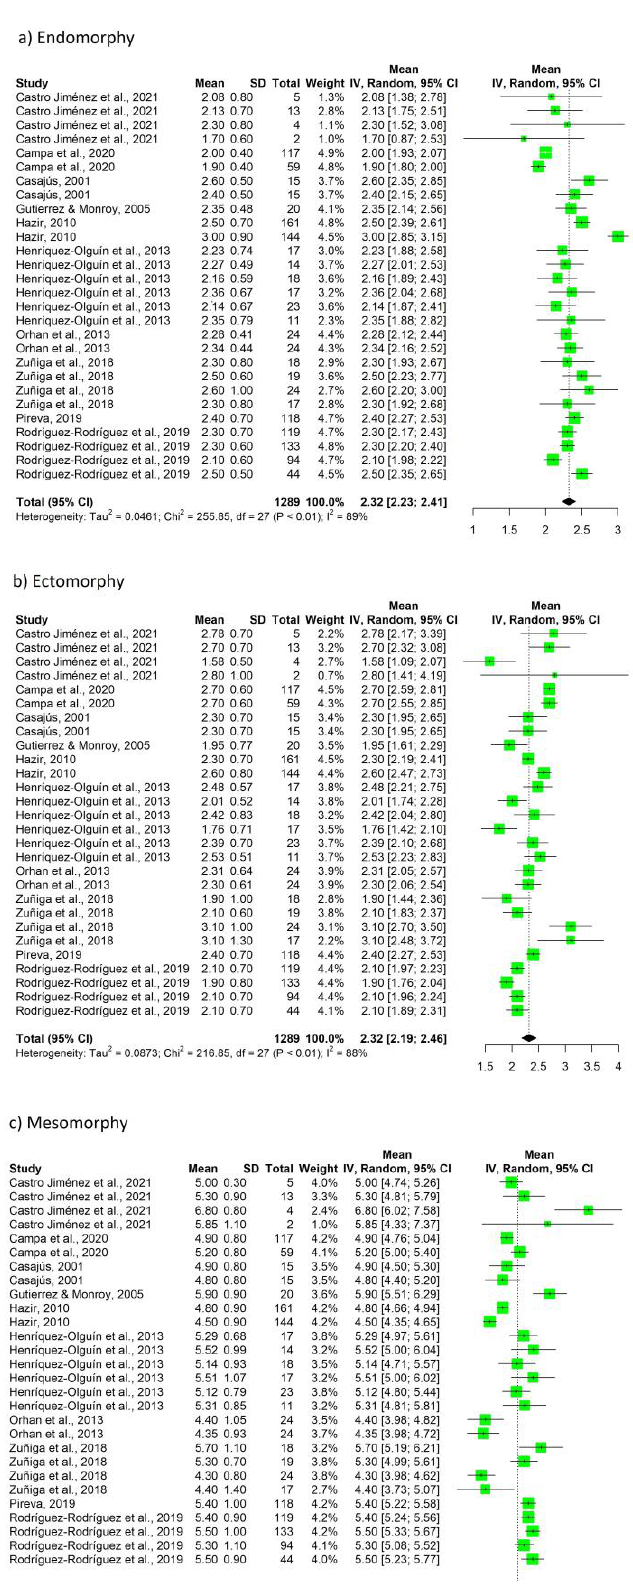
Figure 4. Forest plot ( a ) endomorphy, ( b ) ectomorphy, and ( c ) mesomorphy.